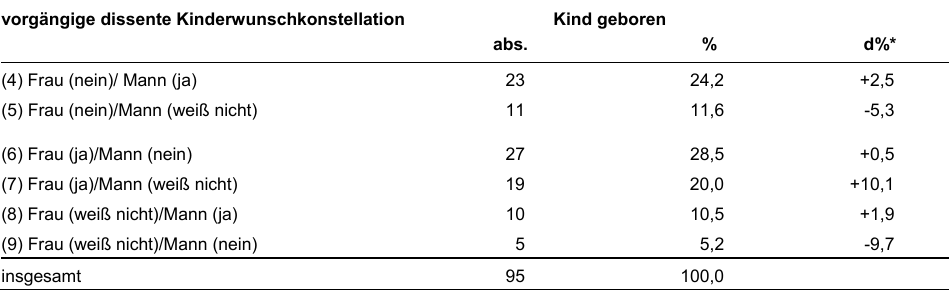
Tabelle 3 : Dissente Paare, die Eltern wurden (alle 4 Wellen) vorgängige dissente